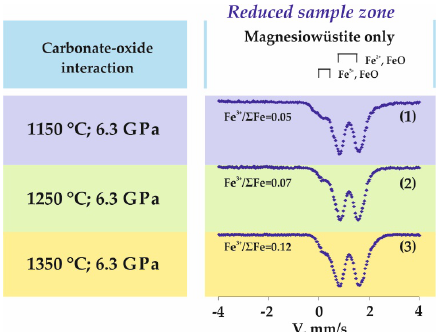
Figure 11. Mössbauer spectra of magnesiowüstite from reduced zones of samples produced in experiments in the carbonate-oxide system.